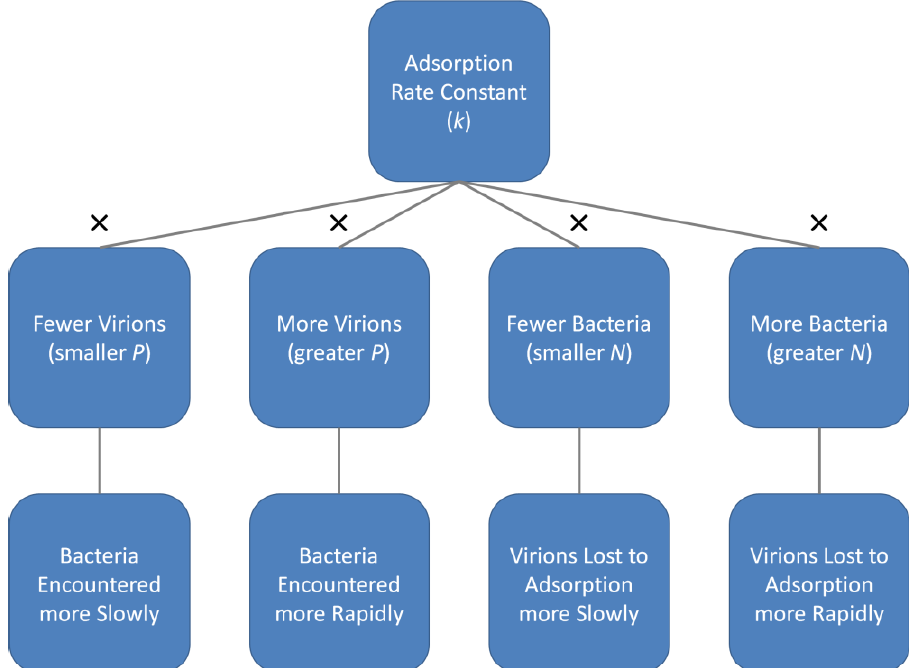
Figure 4. Impact of phage and bacterial concentrations on adsorption rates. “Virions” are as found extracellularly, i.e., as “Free phages”, and “Bacteria” are phage-adsorption susceptible. Variable names are abbreviated as indicated parenthetically and “ × ” refers to the multiplication sign, i.e., as resulting in k × P or k × N . See Appendix A for exploration of the underpinnings of the presented assertions including a visualization of equivalent concepts of free phage and bacterial half-lives as functions of bacterial ( N ) or virion ( P ) densities in environments.